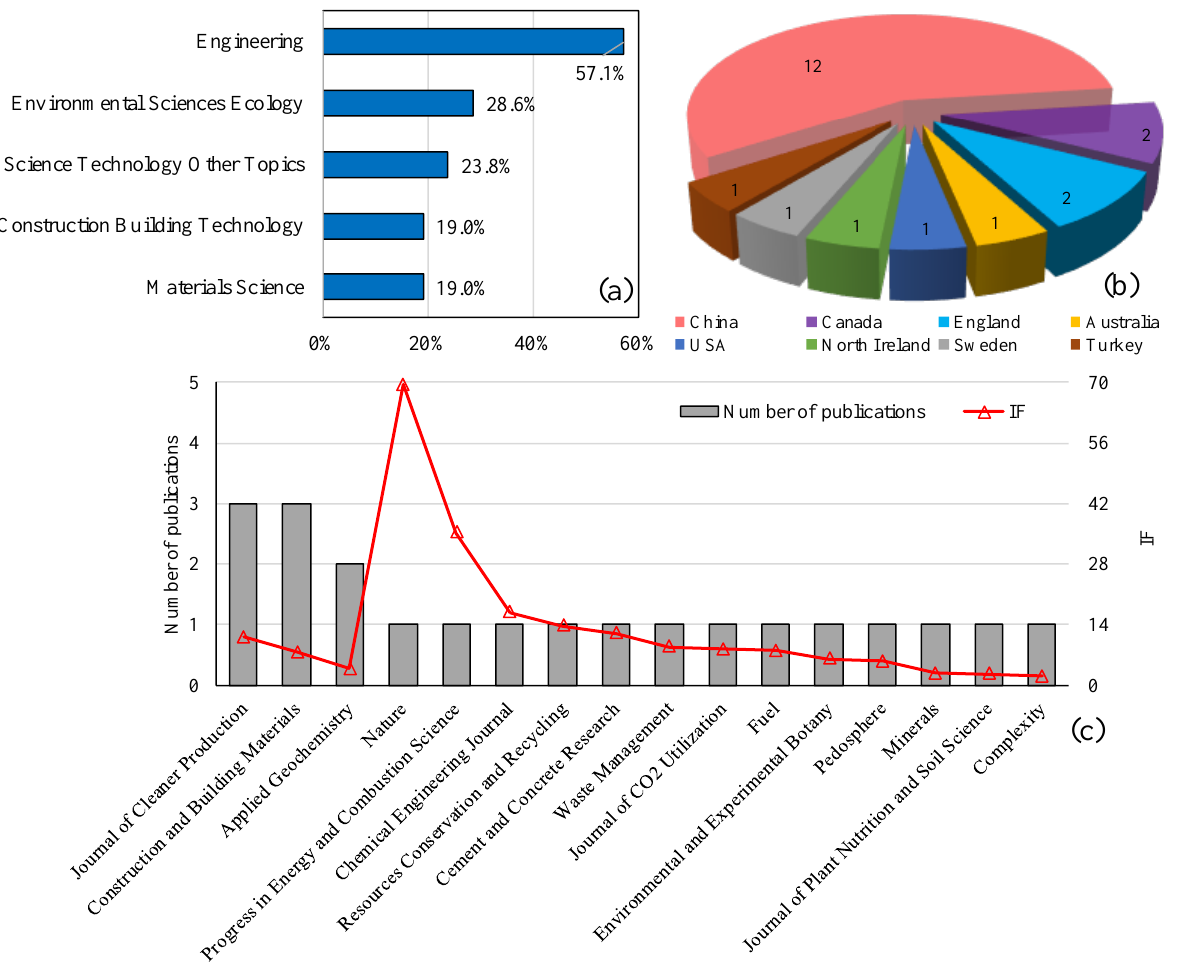
Figure 10. Statistics analysis of ESI highly cited papers on steel slag-related research: ( a ) top five academic fields; ( b ) the distribution of countries; ( c ) the distribution of journals.